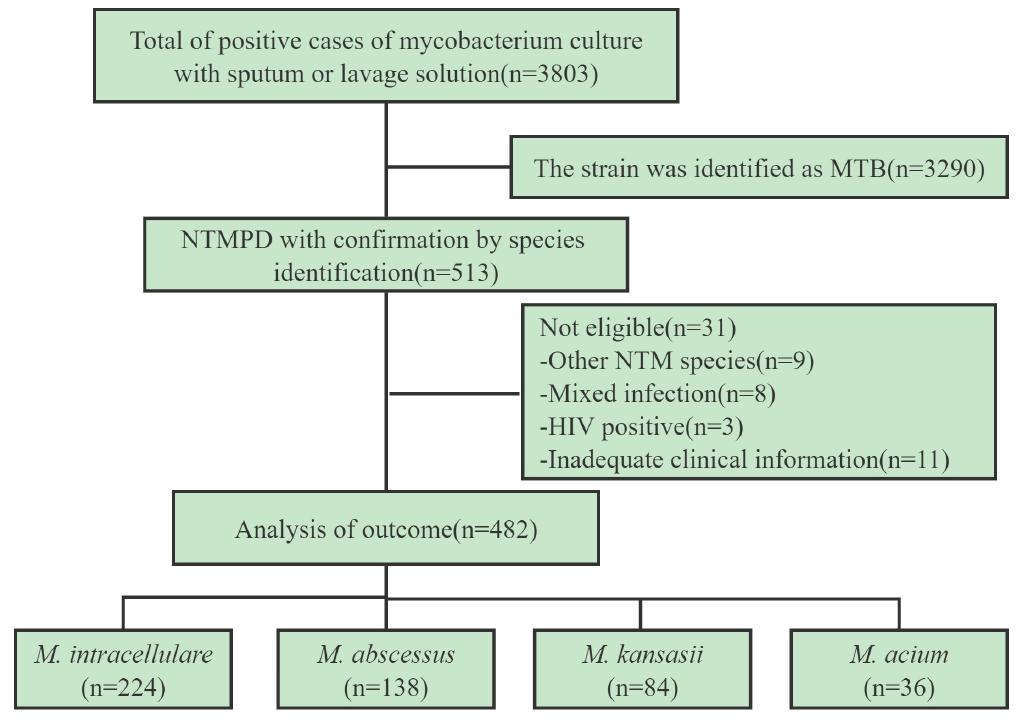
Figure 2. Screening flow chart.